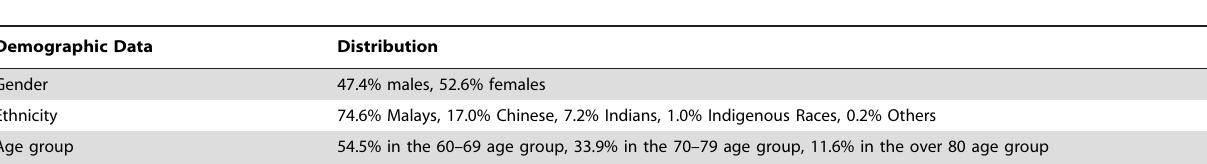
Table 1. Basic demographic data of respondents.